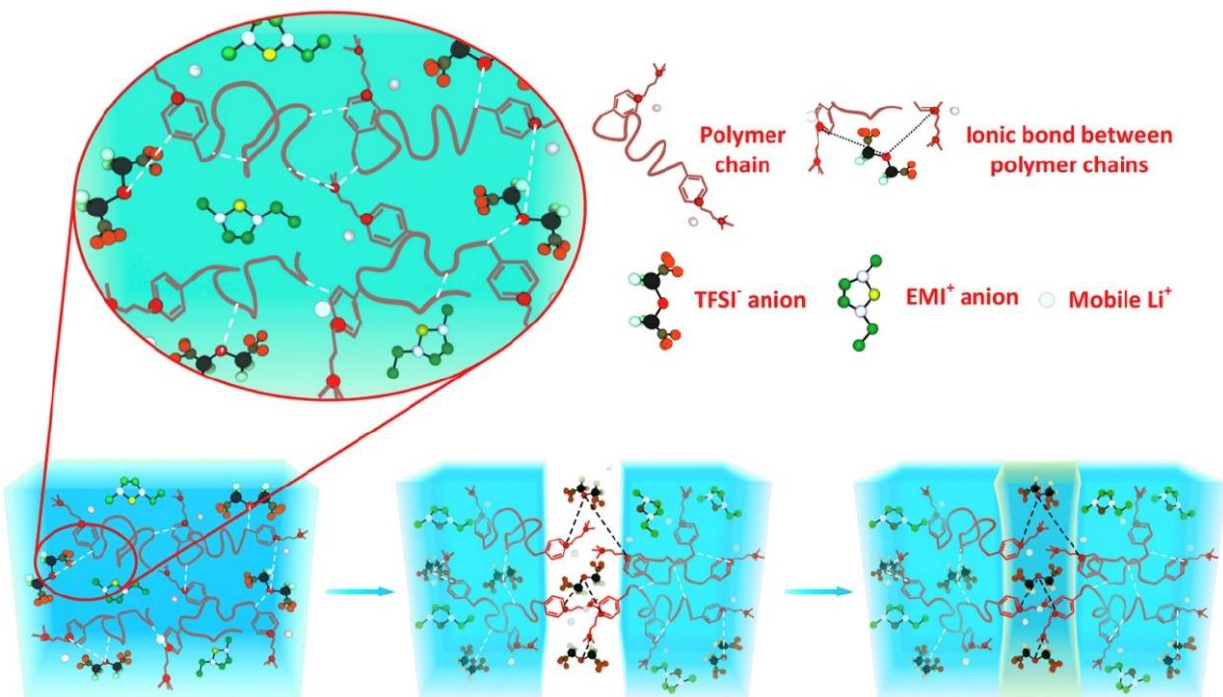
Figure 10. Self-healing mechanism in a PIL-based SPE [261].